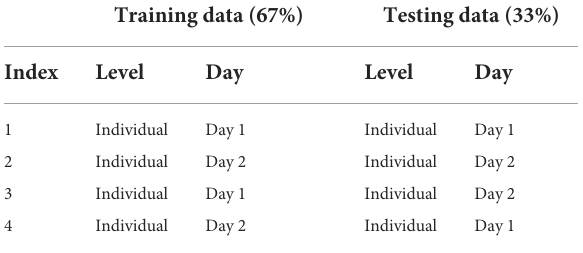
TABLE 2 Summary of individuals’ classifier accuracy to predict number of tasks (single-task, dual-task,